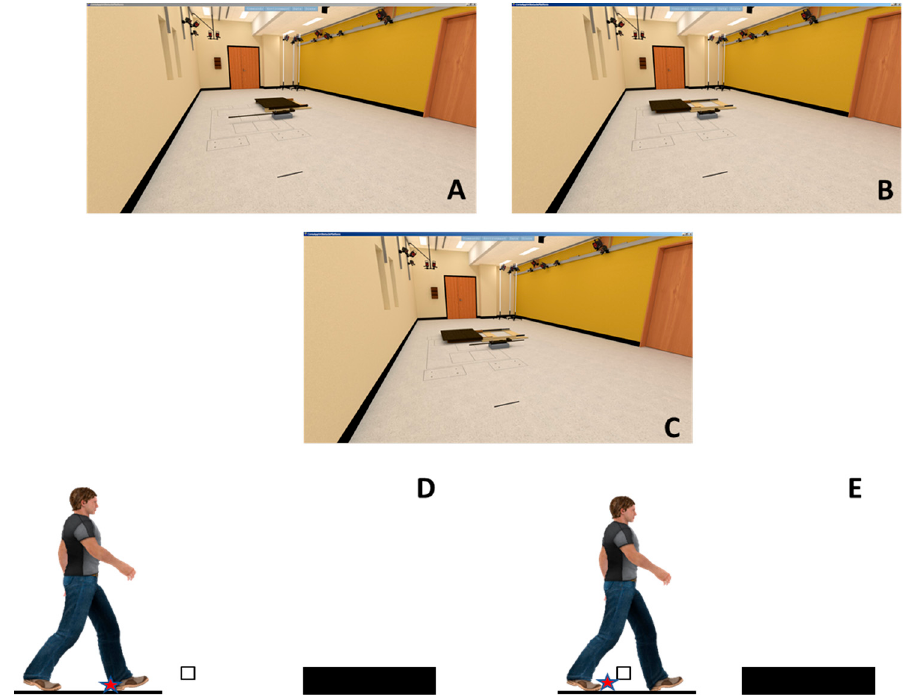
Figure 1. Virtual environment with the obstacle (A), platform (B) and the half obstacle and platform (C). The timing of instantaneous perturbations was triggered by a 20 N load at trailing limb heel contact (D; T1) or at 20 N of unloading at trailing limb toe-off (E; T2).